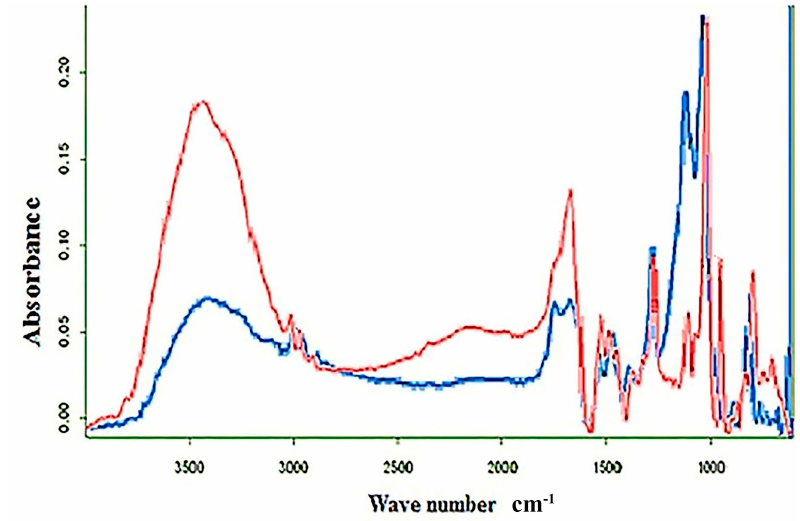
Figure 4. FTIR spectra of CF (red) and FAuNPs (blue).